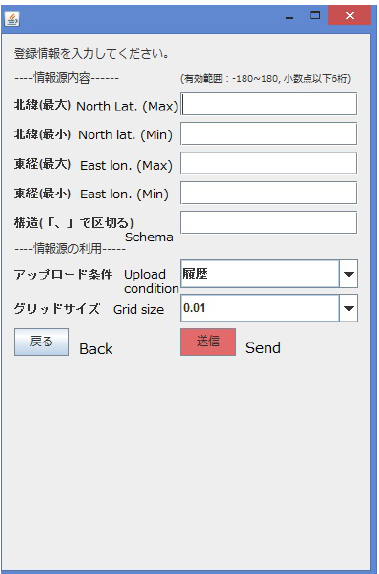
Fig. 8. Registration